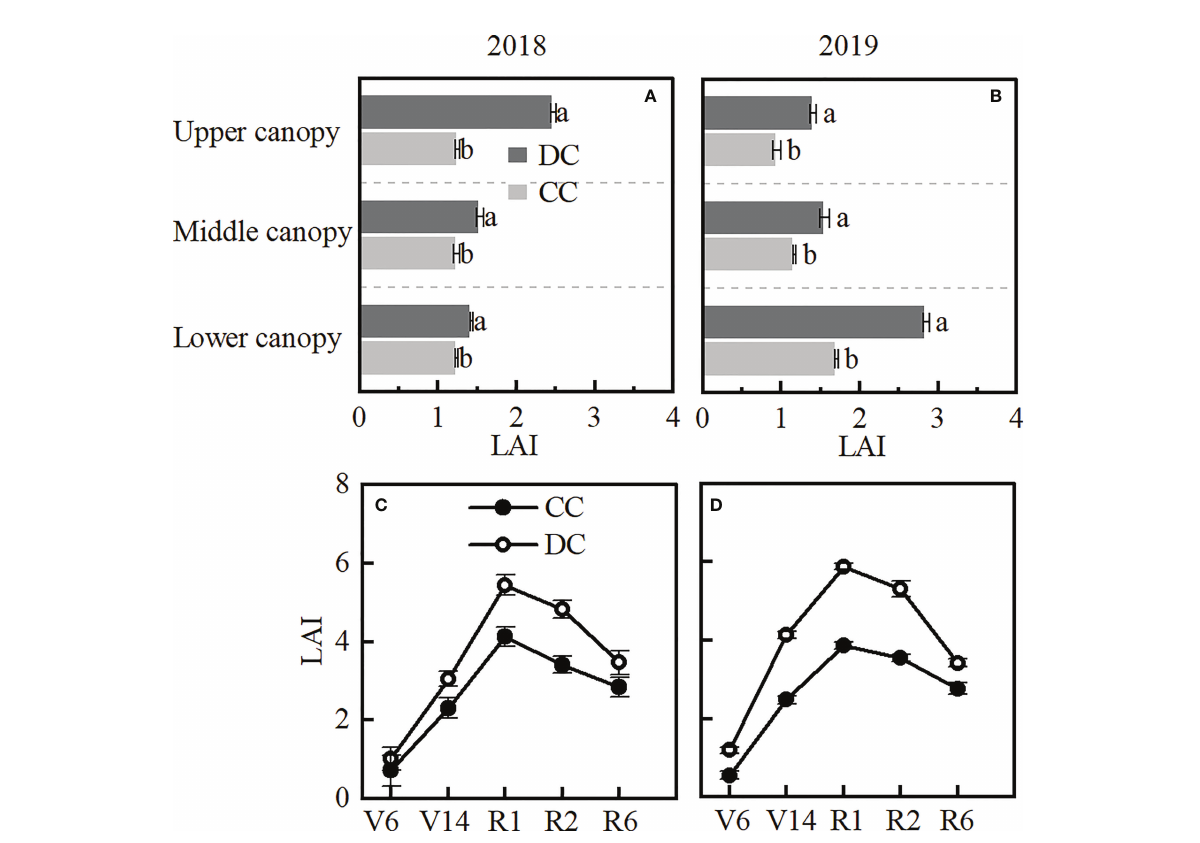
FIGURE 3 LAI of different layers of canopy, and total LAI in different stages. (A, B) : LAI of the upper, middle, and lower canopy at the R1 stage in 2018 and 2019. (C, D) : total LAI of different stages in 2018 and 2019. Upper canopy: above the three-ear leaves. Middle canopy: three-ear leaves. Lower canopy: below the three-ear leaves. DC, Dense cultivation. CC, Common cultivation. Different letters denote signi fi cant differences ( P < 0.05), error bars show standard error of